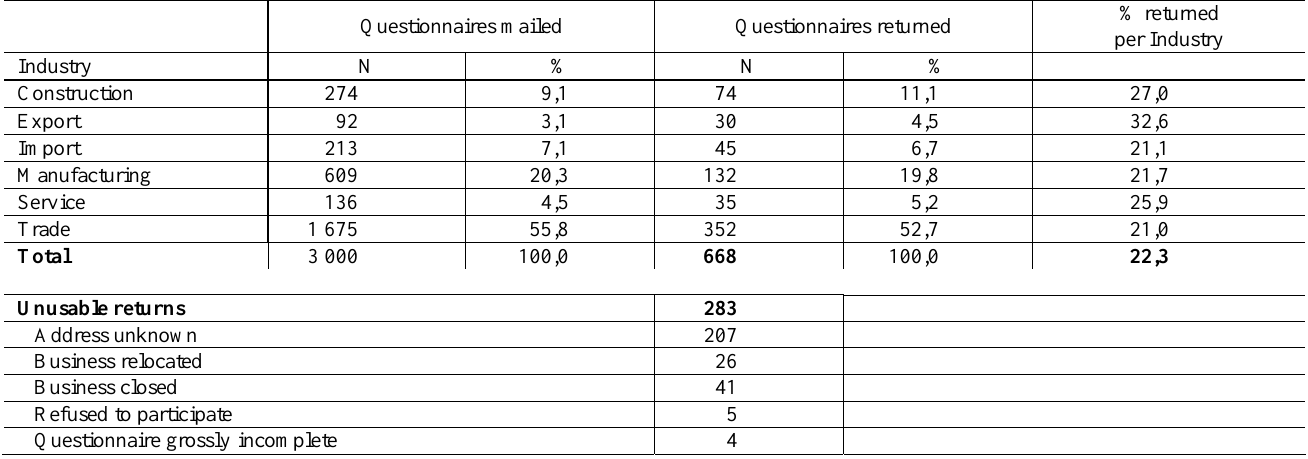
Table 7: Response rate to mailed questionnaires Questionnaires